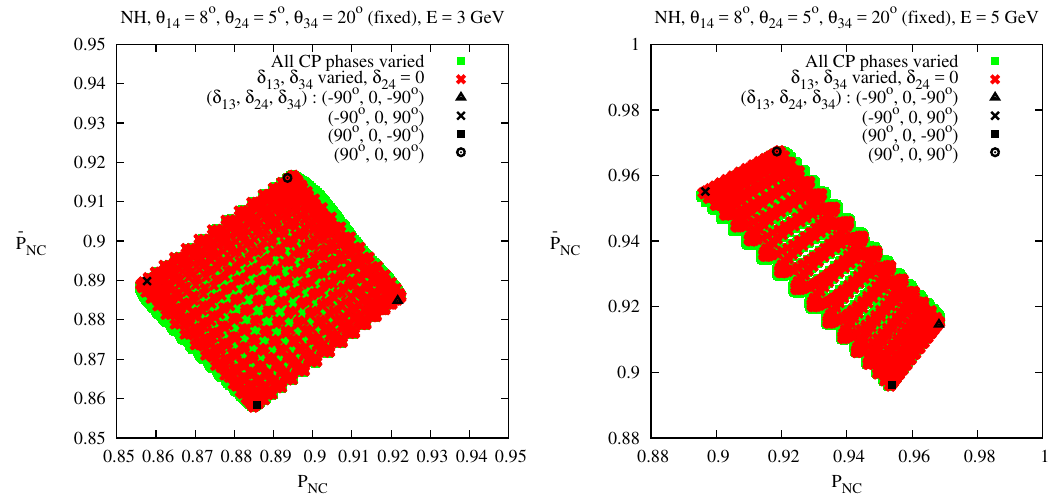
Figure 6 . (cid:22) P NC vs P NC at E = 3 GeV (left-panel) and at E = 5 GeV (right-panel) for L = 1300 km in the presence of matter. (cid:18) 14 = 8 (cid:14) ; (cid:18) 24 = 5 (cid:14) ; (cid:18) 34 = 20 (cid:14) ((cid:12)xed). Green region: this region corresponds to all (cid:22) P NC - P NC values that are obtained when all the three CP phases are varied in [ (cid:0) 180 (cid:14) ; 180 (cid:14) ]. Red region: this region corresponds to all (cid:22) P NC - P NC values that are obtained when (cid:14) 13 and (cid:14) 34 are varied in [ (cid:0) 180 (cid:14) ; 180 (cid:14) ] while (cid:14) 24 = 0. Black points: (cid:14) 13 ; (cid:14) 34 2 f(cid:6) 90 (cid:14) ; (cid:6) 90 (cid:14) g when (cid:14) 24 =